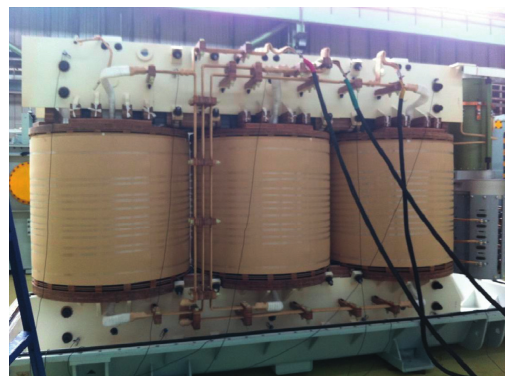
Figure 18: Noise and vibration tests of the core under no-load